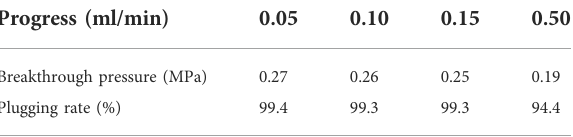
TABLE 6 Breakthrough pressure and plugging coef fi cient in cores under different injection rates. Progress